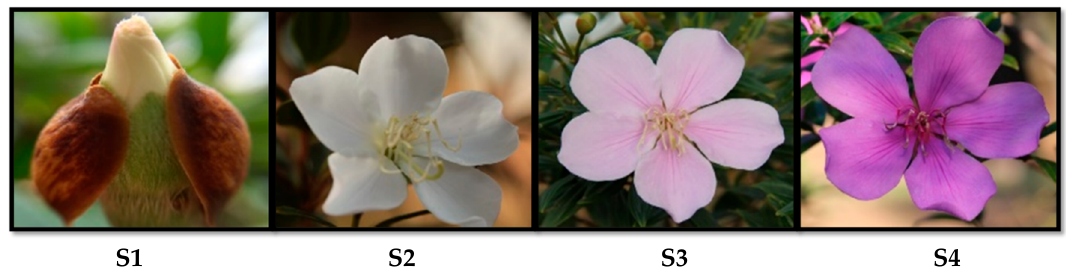
Figure 1. Stages of the floral colour change of Pleroma raddianum . S1 — buds (day 0), S2 — white flowers (day 1), S3 — pink (day 2), S4 — purple (day 3).